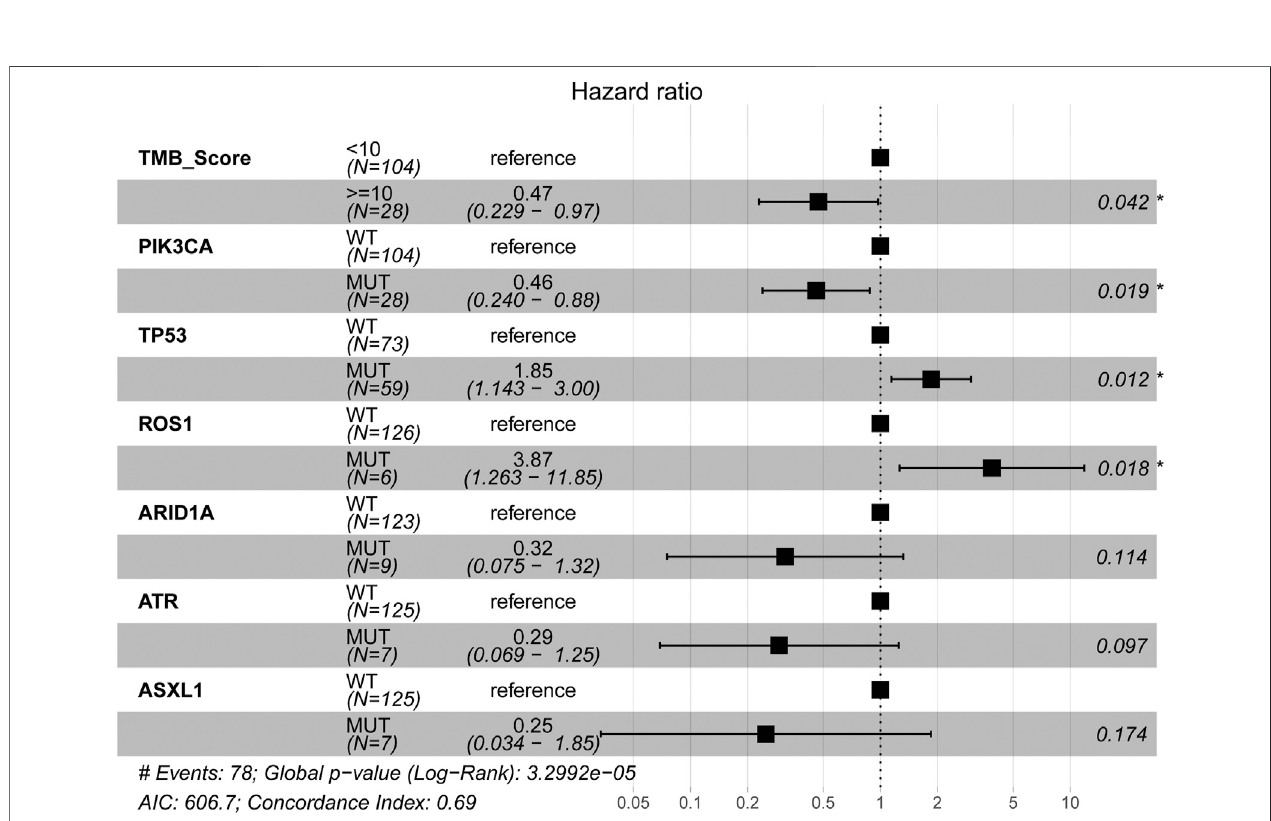
FIGURE 4 | Multivariate Cox regression analysis of TMB and six genes, PIK3CA , TP53 , ARID1A , ROS1 , ATR , and ASXL1 . TMB, tumor mutational burden.